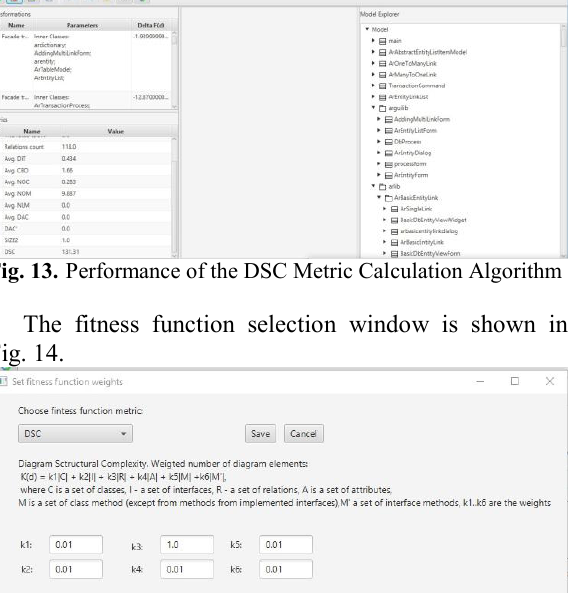
Fig. 12. The value of the execution time was calculated as the average execution time measured during 10000 runs for each UML class diagram size.